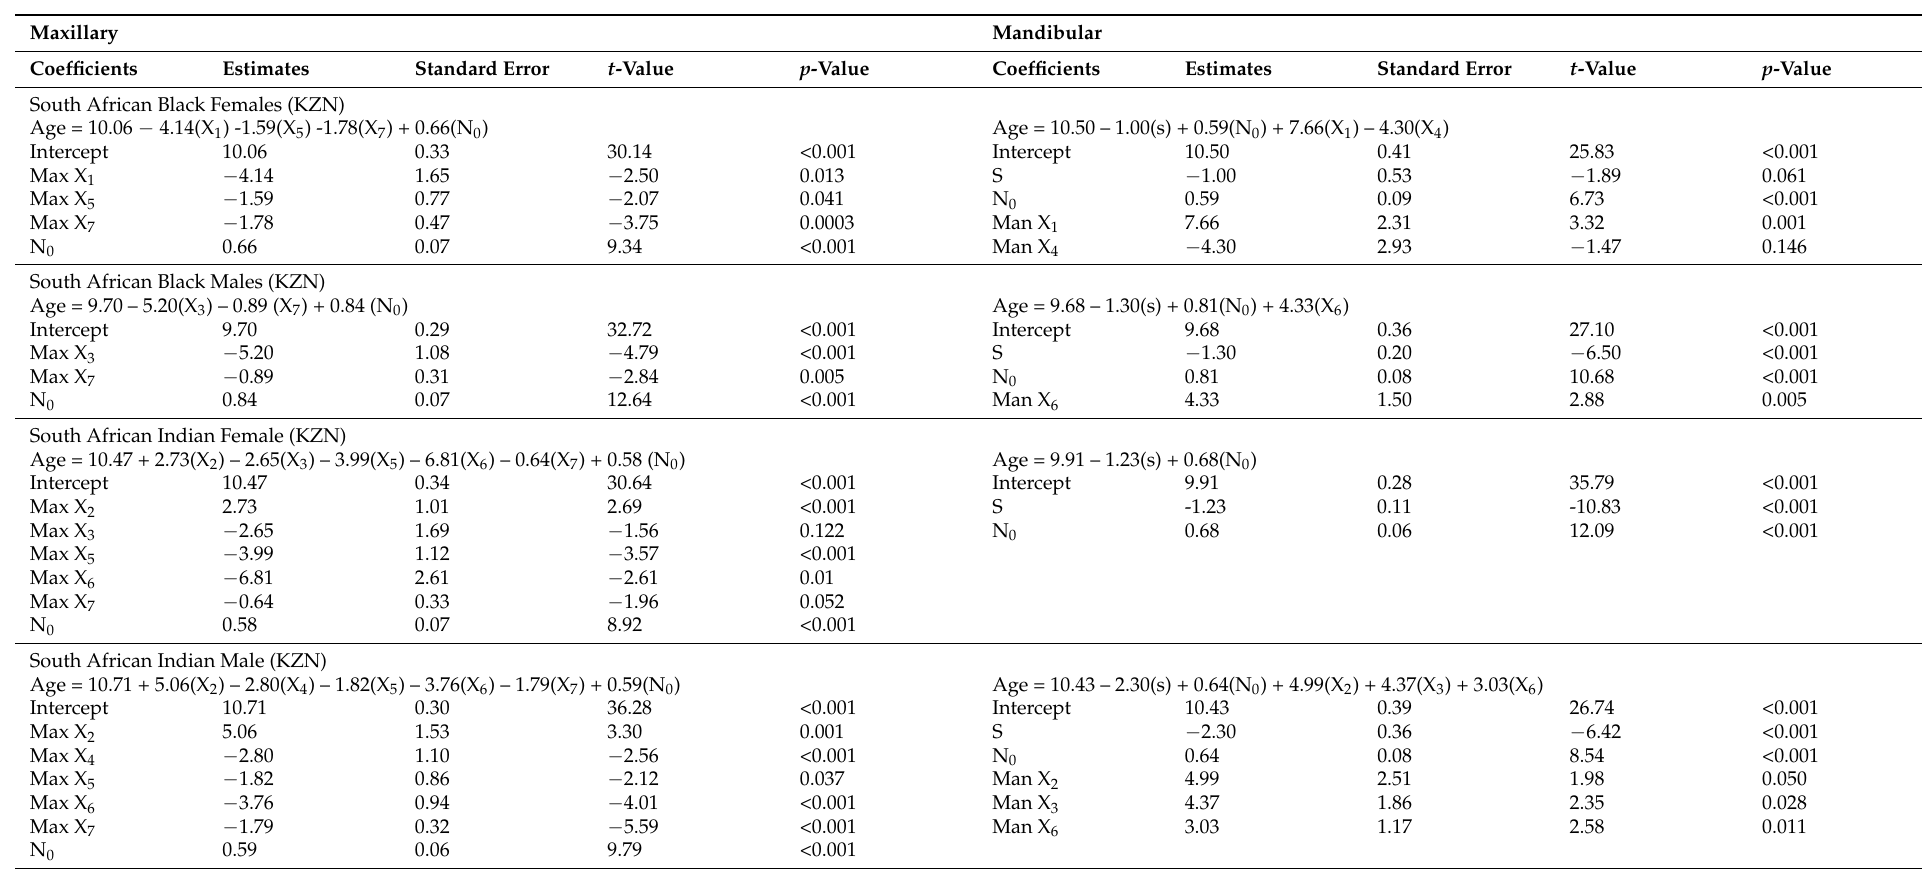
Table 4. Estimation of chronological age using step-wise regression analysis for South African Black and Indian population groups of KZN in individuals aged between 5.00 and 15.99 years (excluding third